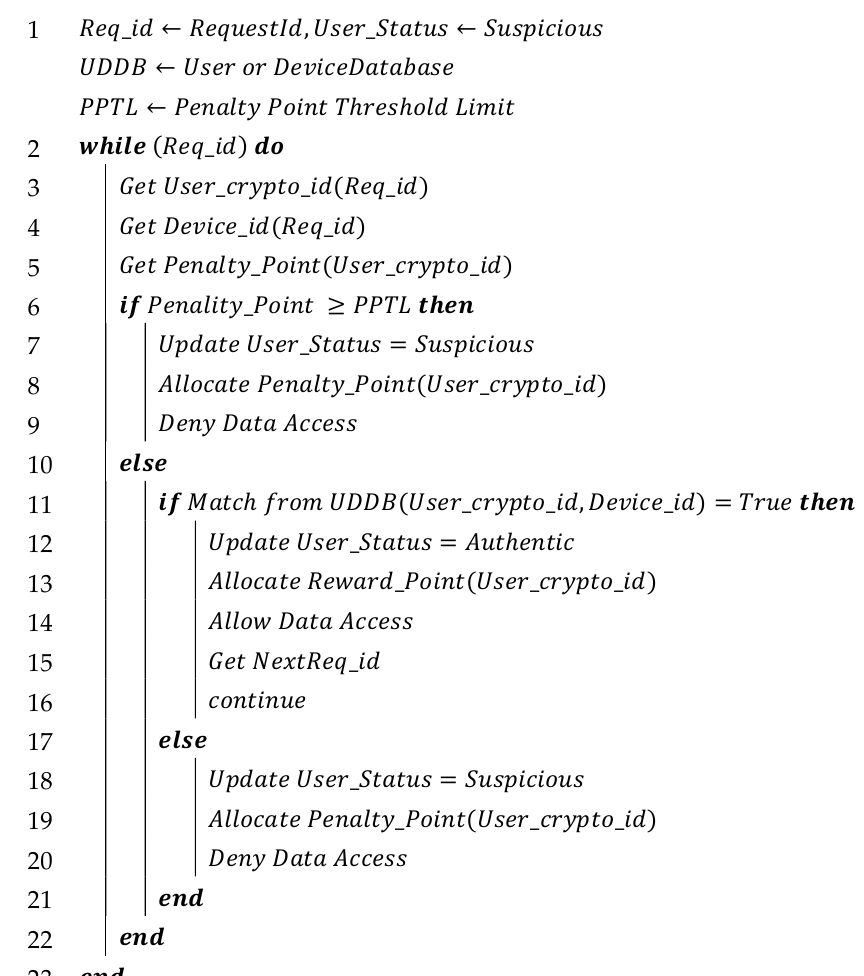
Algorithm 3: Local Trust Point (LTP) User Authentication